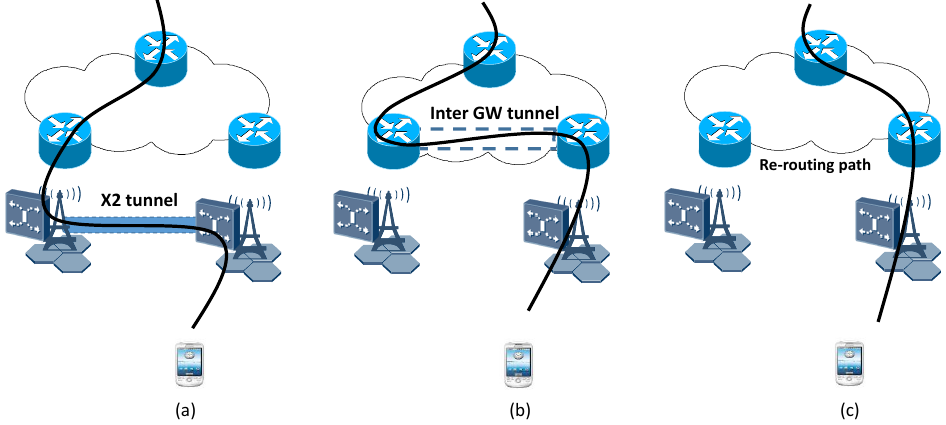
Figure 8. Three main steps of handover procedure with gateway relocation in proposed 5G concept: ( a ) establishing X2 tunnel, ( b ) inter M-GW tunnel, and ( c ) switching destination